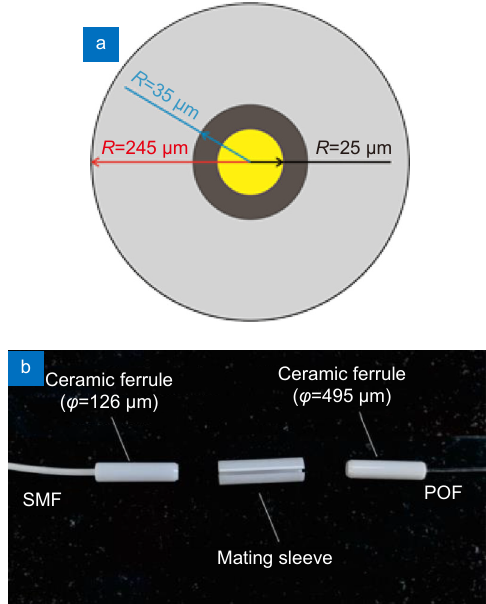
Fig. 5 | ( a ) Cross section of the POF. ( b ) Connection between POF and SMF using ceramic ferrule and ceramic mating sleeve.